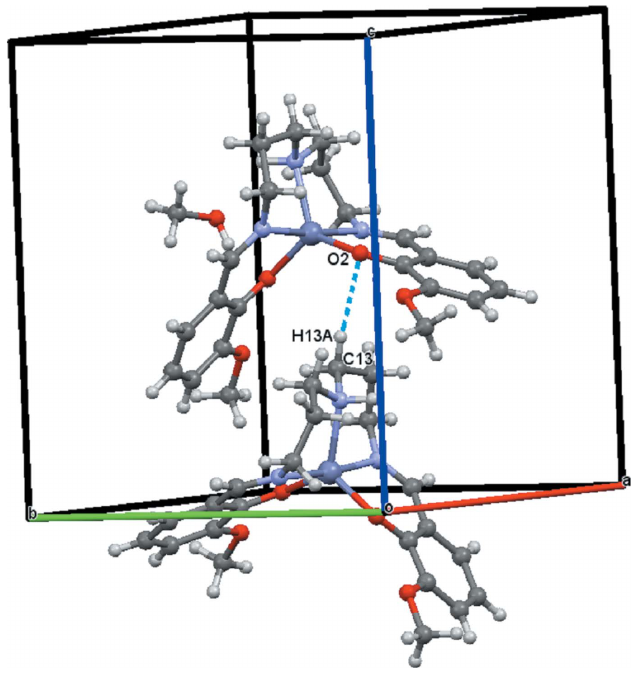
Figure 3 A view of the C13—H13 A (cid:2)(cid:2)(cid:2) O2 interaction (dashed